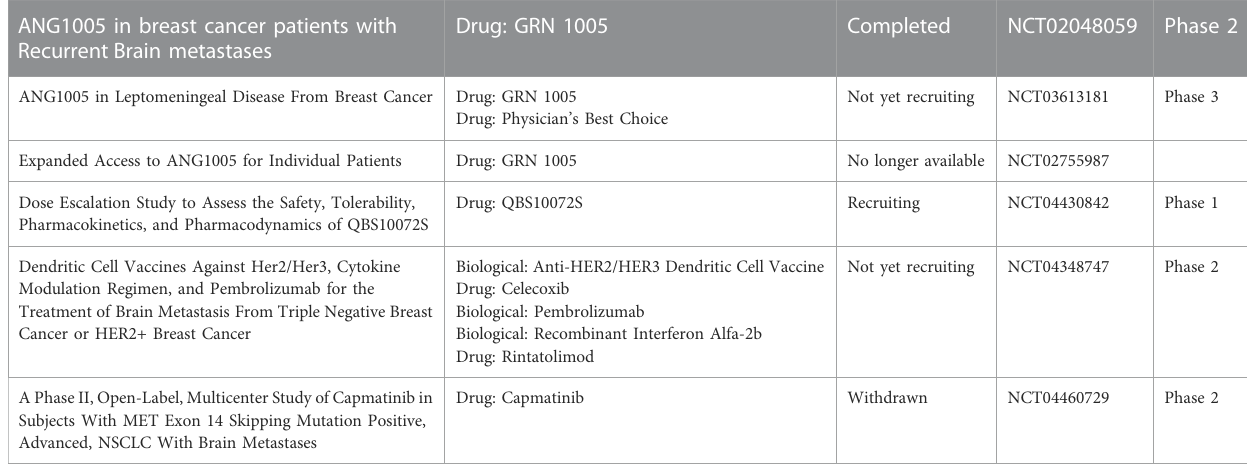
been applied to other fi elds of cancer in the past, while until recently has it been tested in BrM. Microenvironment targeted therapies used here are marked red. ANG1005 in breast cancer patients with Recurrent Brain